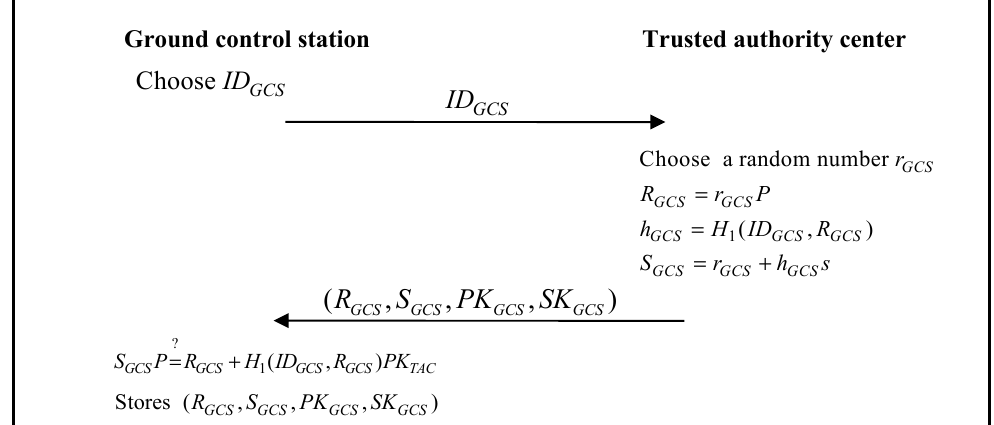
Figure 4. Ground control station registration phase of the proposed scheme.